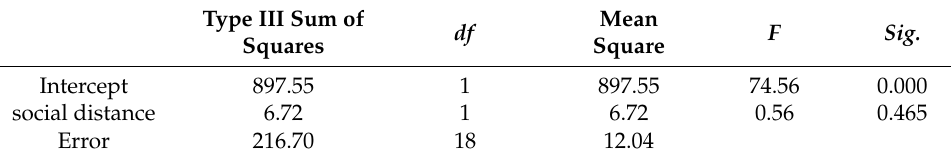
Table 7. Tests of Between-Subjects Effects of N1 amplitude (promotion focus).